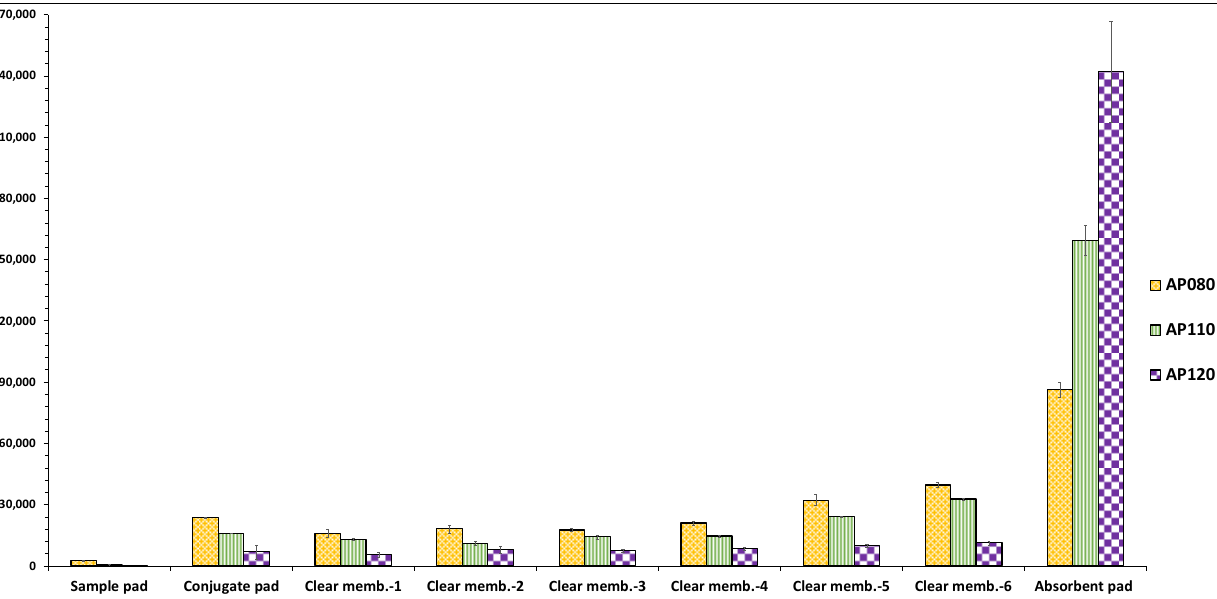
Figure 8. Effect of absorption efficiency of different types of absorbent pads on the sensitivity of the vertical flow assay.